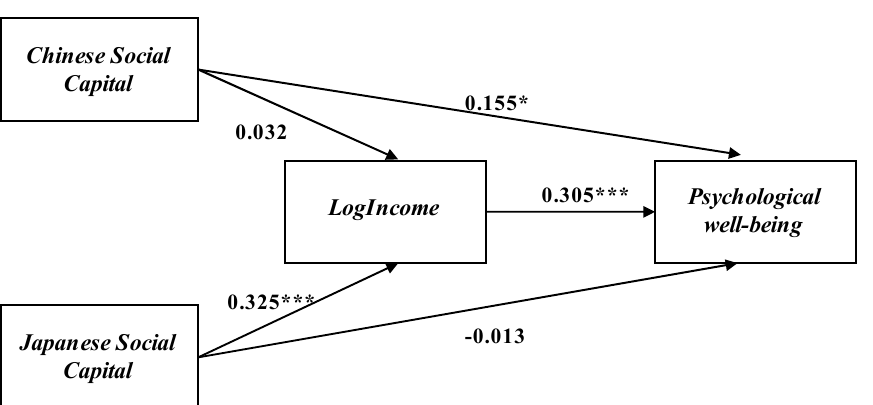
Figure 2. Path model for Chinese immigrants’ social capital, income, and psychological well-being.